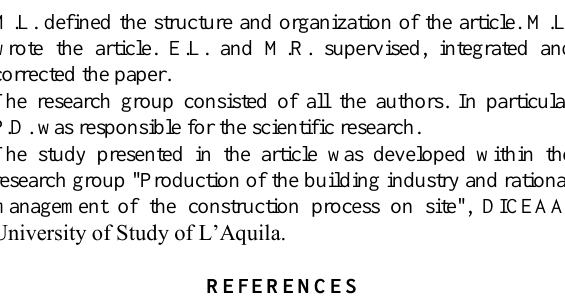
Figure 4. Worksharing. Team members share a central model